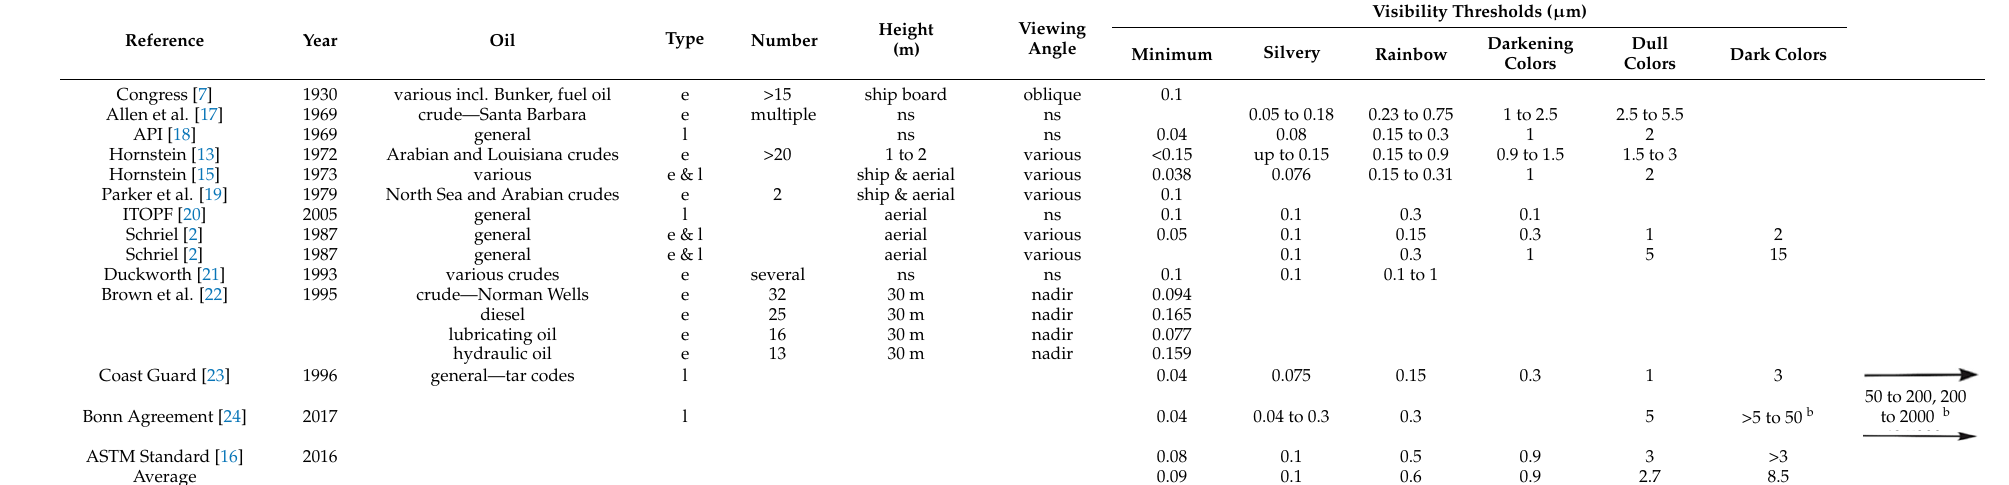
Table 4. Summary of Appearance Color Codes.